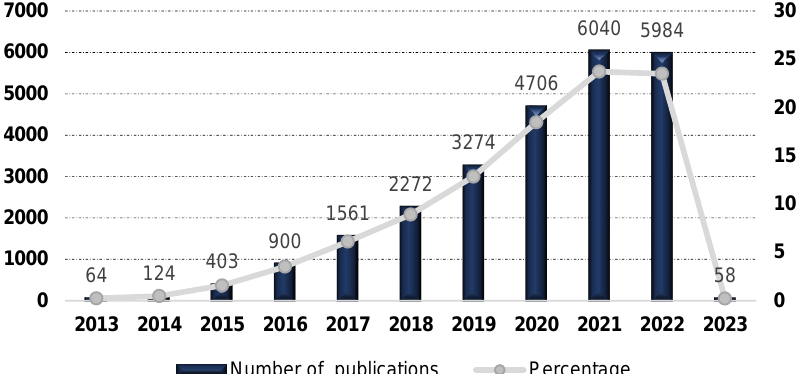
Figure 1. Number of publications and percentages per year covering ICIs in cancer topics, period 2013–2023. Data source from Web of Science™ Core Collection.